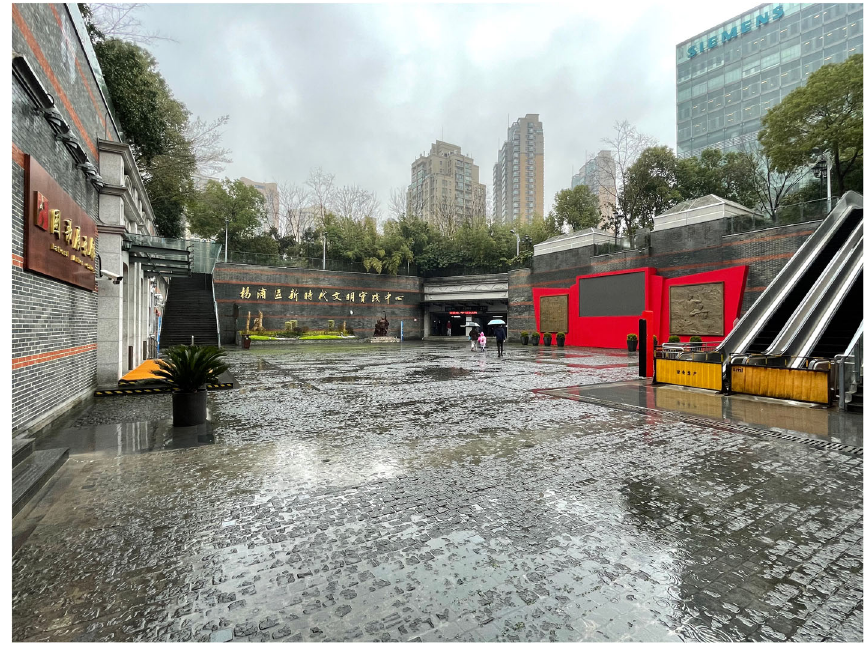
Fig. 10 Entrance to the National Anthem Gallery (left), in the sunken plaza of Tilanqiao Station (line 4). (Source: the